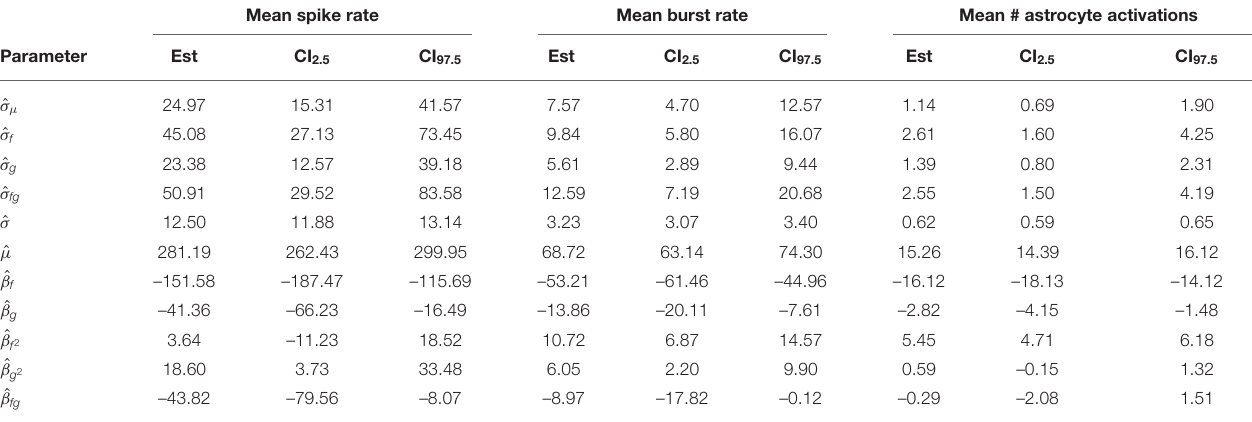
TABLE 5 | Restricted maximum likelihood estimates, lower and upper ends of 95 % confidence intervals for the glutamate dynamics experiment. Mean spike rate Mean burst rate Mean # astrocyte activations